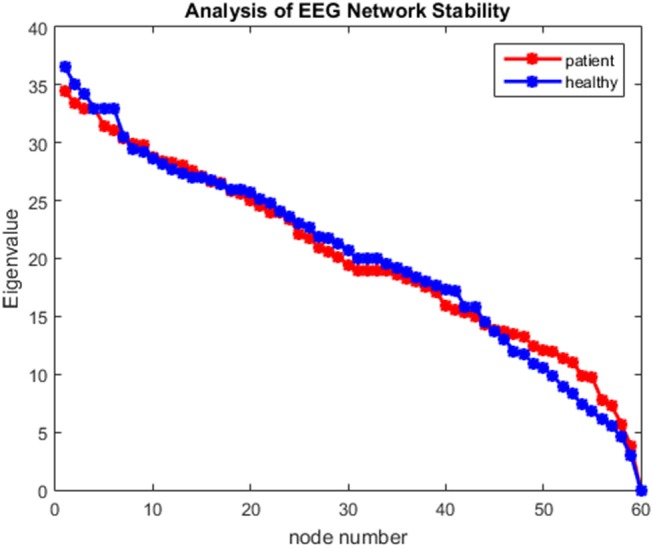
EEG Working memory data Laplacian eigenvalue spectrum (descending order) diagram.